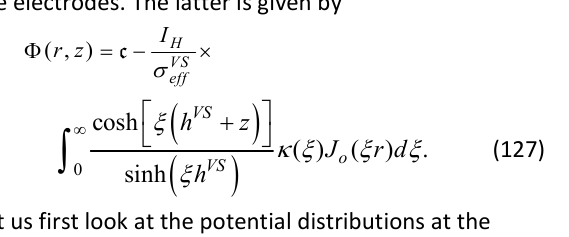
Fig.7: The absolute value of the potential distribution at 1 MHz for the base case in the viable skin: (a) the complete model; (b) the reduced model; and (c) the approximate solution from the Hankel